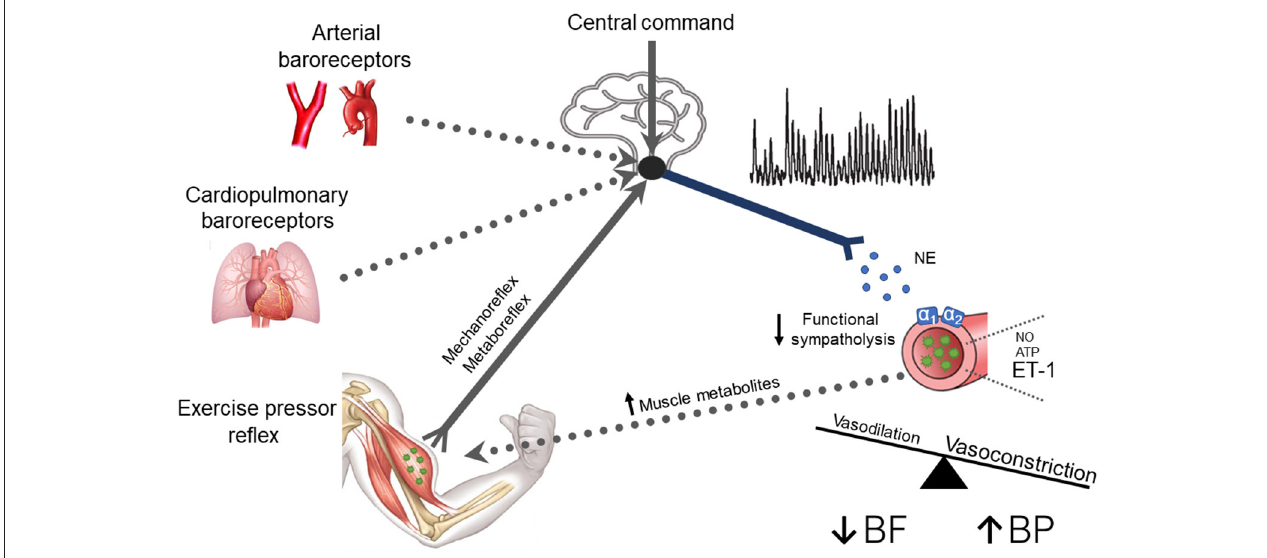
FIGURE 2 | A schematic of potential neural mechanisms responsible for neurovascular dysregulation in type 2 diabetes (T2D). Current evidence supports a contribution of the exercise pressor reflex and central command (solid lines), whereas the contribution of the arterial and cardiopulmonary baroreflex remains unclear (dotted lines). Briefly, T2D patients exhibit exaggerated muscle sympathetic nerve activity (MSNA) responses, which increases the release of norepinephrine (NE) binding to α 1 and α 2 adrenergic receptors causing constriction of peripheral vascular beds. T2D may also impair the normal ability to attenuate sympathetically mediated vasoconstriction in active skeletal muscle (i.e., reduced functional sympatholysis). Additionally, enhanced endothelin-1-mediated vasoconstriction and reduced nitric oxide (NO) and adenosine triphosphate (ATP) mediated vasodilation may also contribute to the reduced exercise hyperemia in T2D. These alterations favor vasoconstriction, leading to reduced active skeletal muscle blood flow and exaggerated BP responses to exercise. Thus, it is plausible that T2D leads to a positive feedback scenario where enhanced MSNA and reduced functional sympatholysis combined with other impaired local vascular control pathways